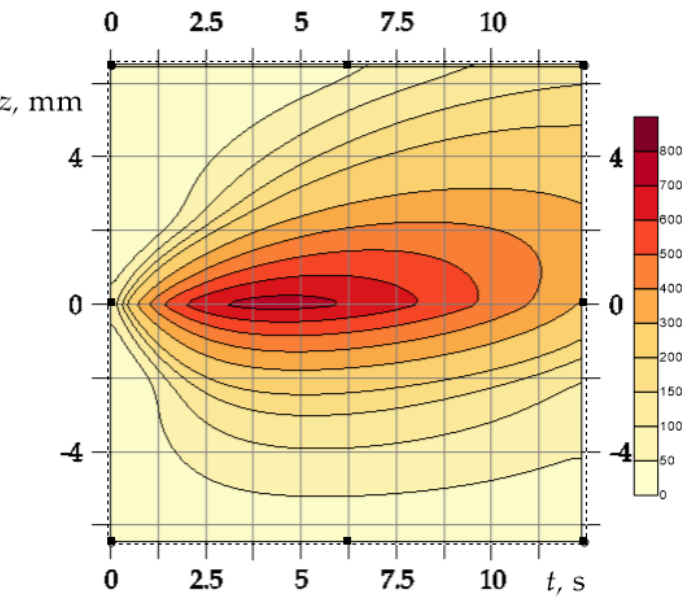
Figure 2. Isotherms of the temperature rise Θ ( z , t ) in the disc and the pad at t i = 0.5 s.